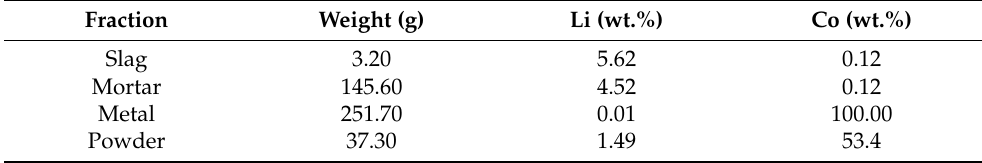
Table 3. Analysis results of the fractions of the experiment LCO-C in Design 1.